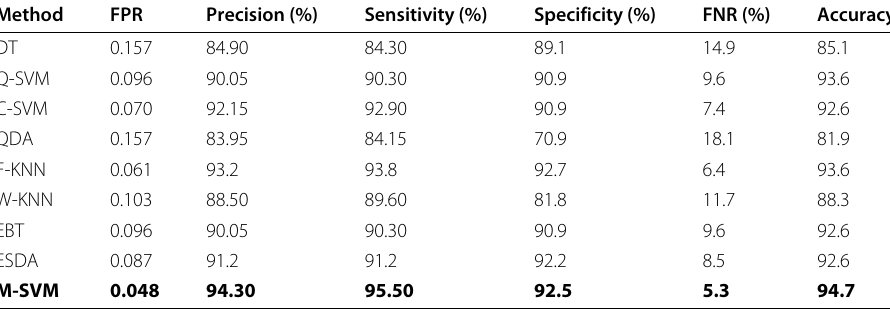
Table 9 Classification results on the proposed feature selection approach for apple rust Method